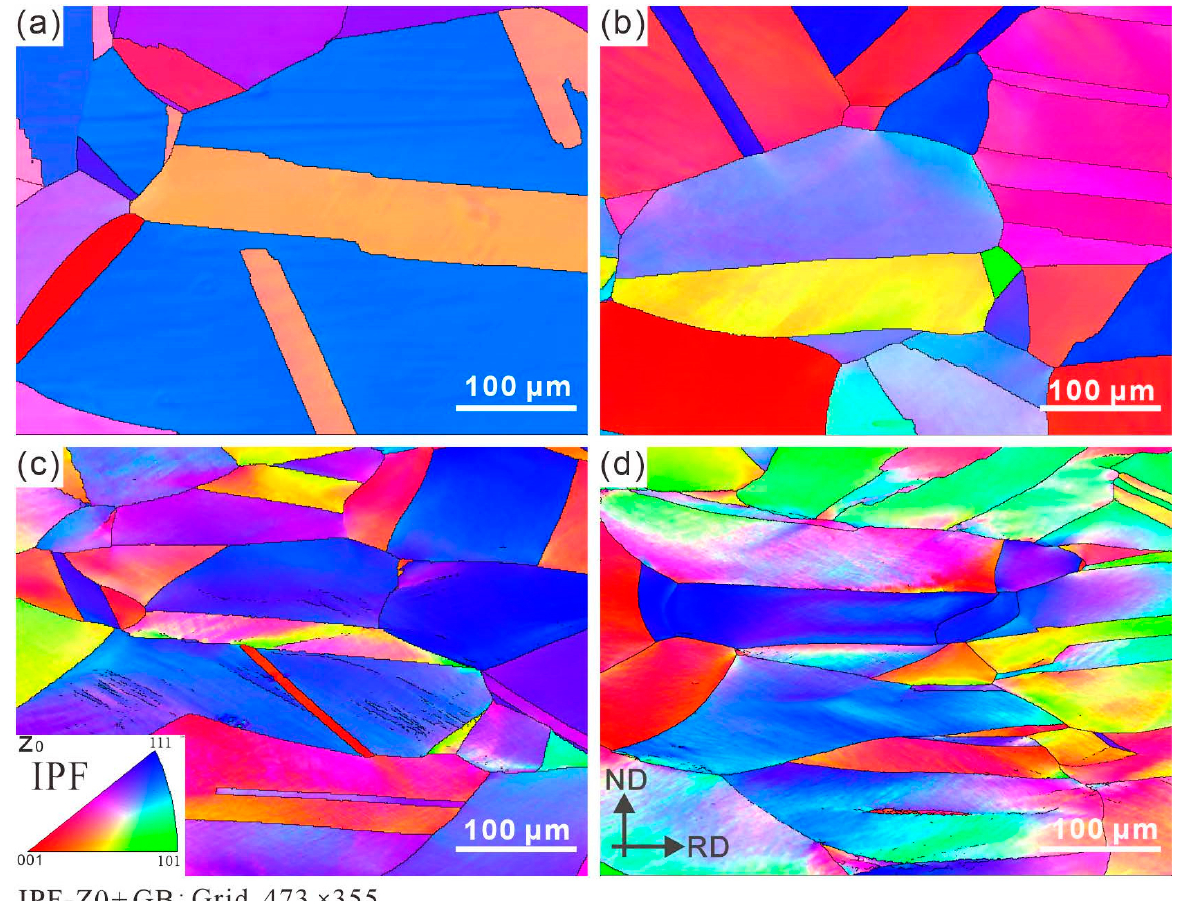
Figure 3. EBSD images of copper with different degrees of deformation: ( a ) undeformed, ( b ) 10%, ( c ) 20% and ( d ) 30%.